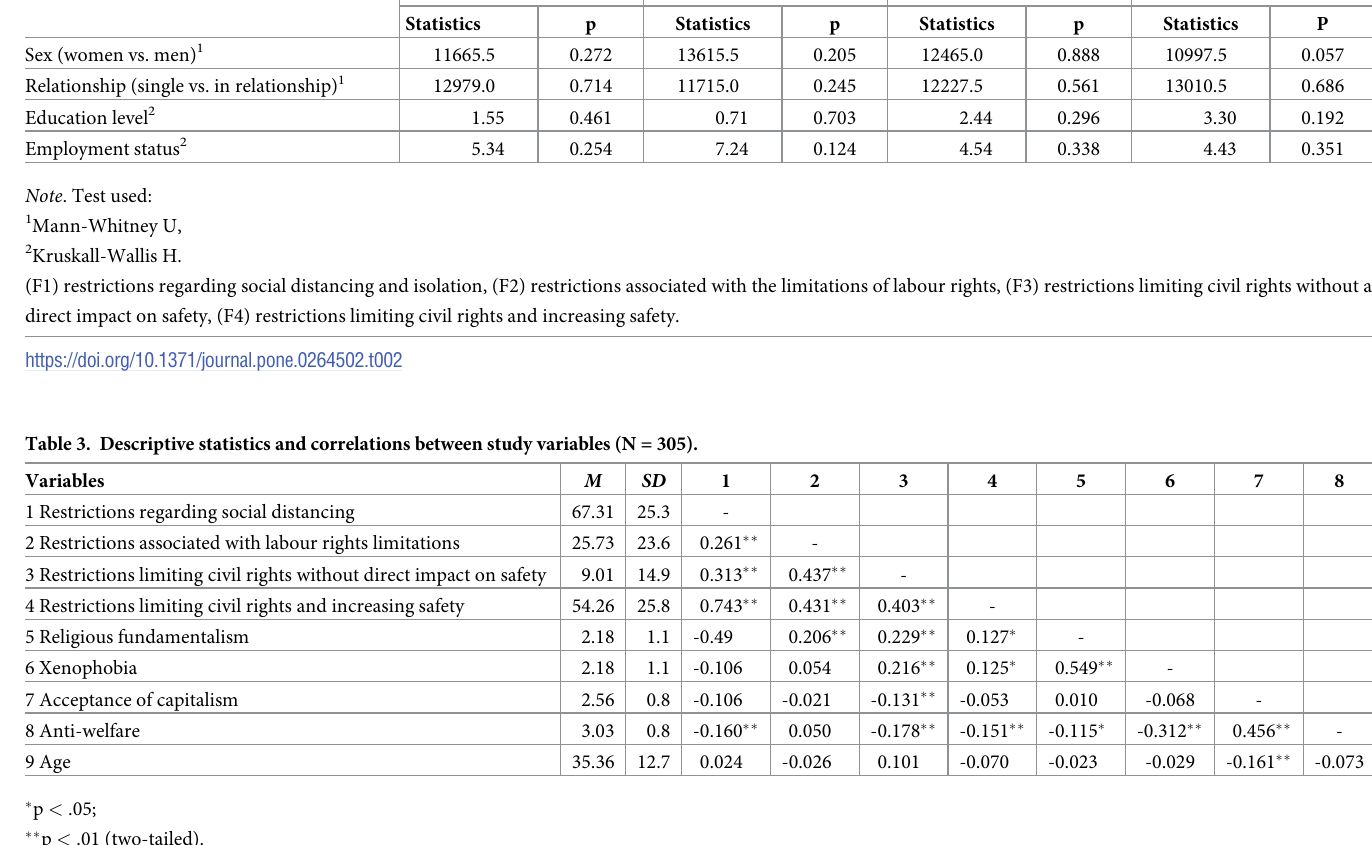
Table 2. The differences in the acceptance of the four groups of the restrictions between the groups of participants distinguished on the basis of sex, relationship status, education level and employment (N = 305). Variables